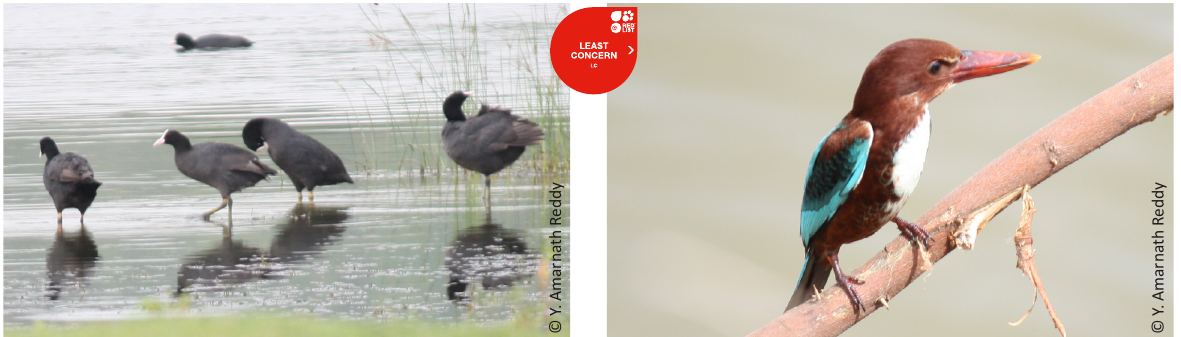
Image 14. Halcyon smyrnensis White-breasted Kingfisher